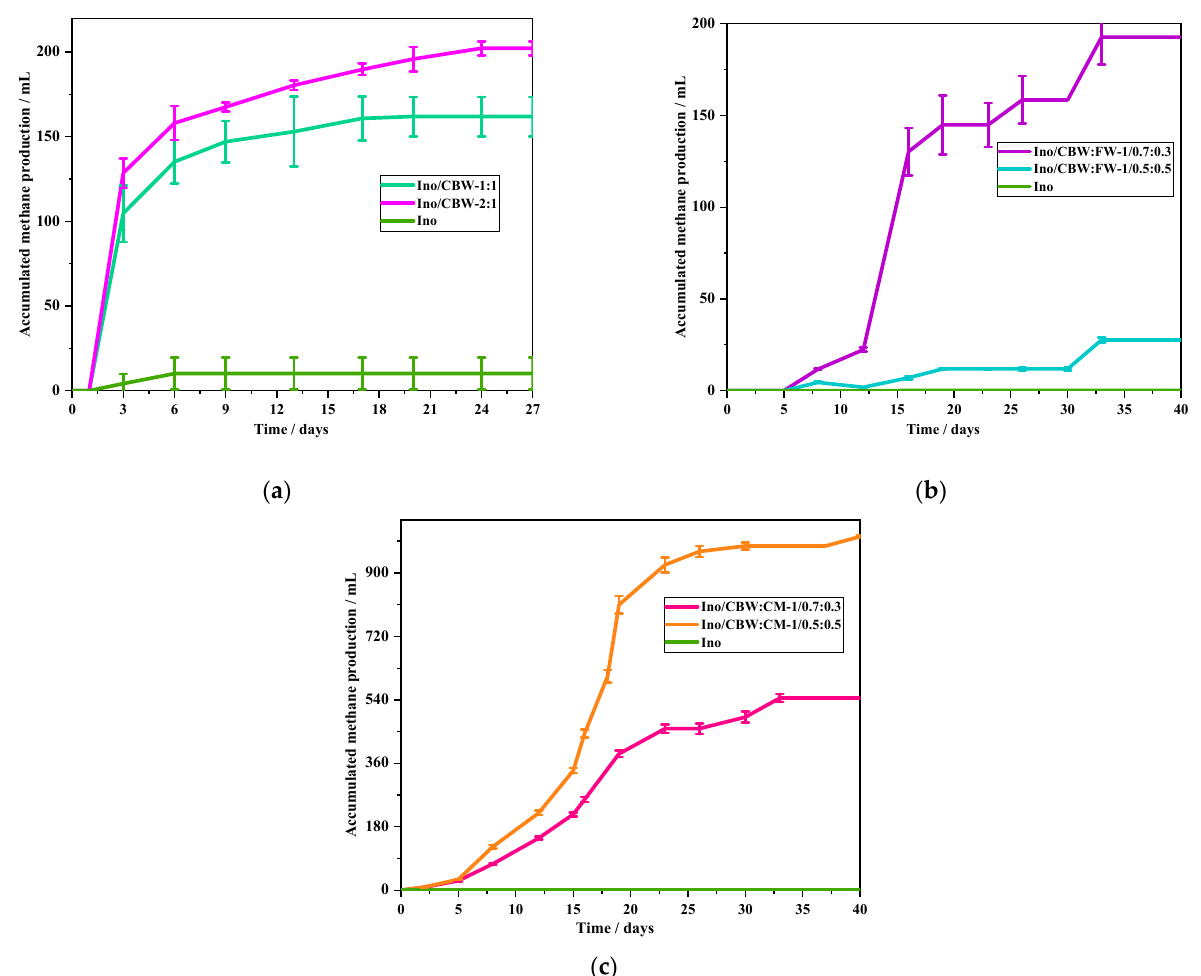
Figure 2. Accumulated of methane for CBW digestion tests ( a ) AD of different ratios of mixture of inoculum and cork boiling wastewater (Ino/CBW); ( b ) anaerobic digestion of different ratios of mixture of inoculum, cork boiling wastewater, and food waste (Ino/CBW:FW); ( c ) anaerobic digestion of different ratios of mixture of inoculum, cork boiling wastewater and cow manure (Ino/CBW:CM).